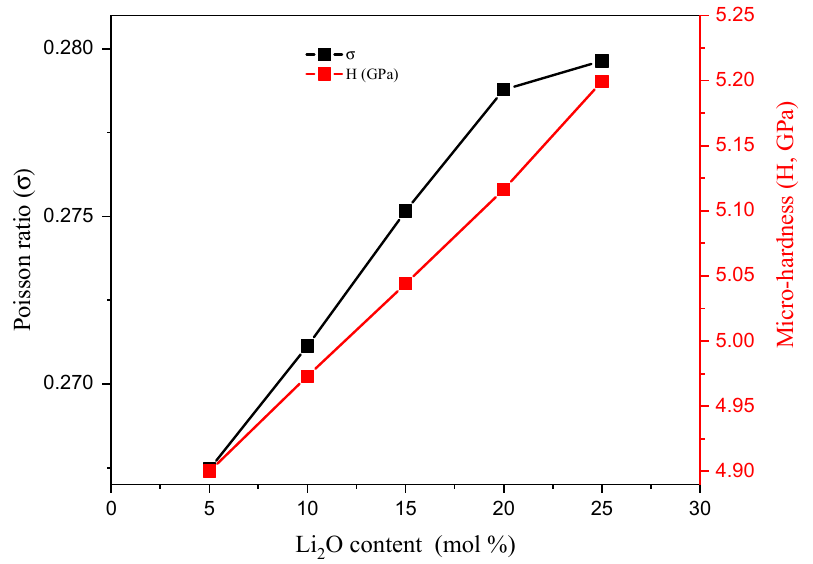
Figure 5. Variation in the Poisson ratio and microhardness for the fabricated TABLi glasses as a function of the Li 2 O insertion ratio.